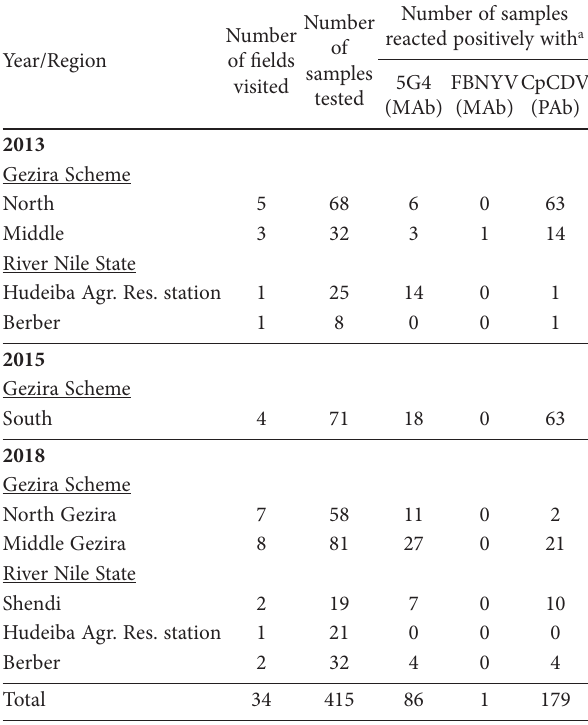
Table 2. Results of serological tests (Tissue blot immunoassay, TBIA) for chickpea samples collected from different regions of Sudan during the 2013, 2015 or 2018 growing seasons.